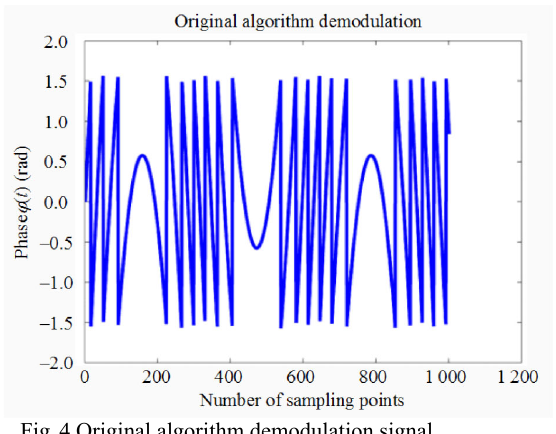
Fig. 4 Original algorithm demodulation signal.